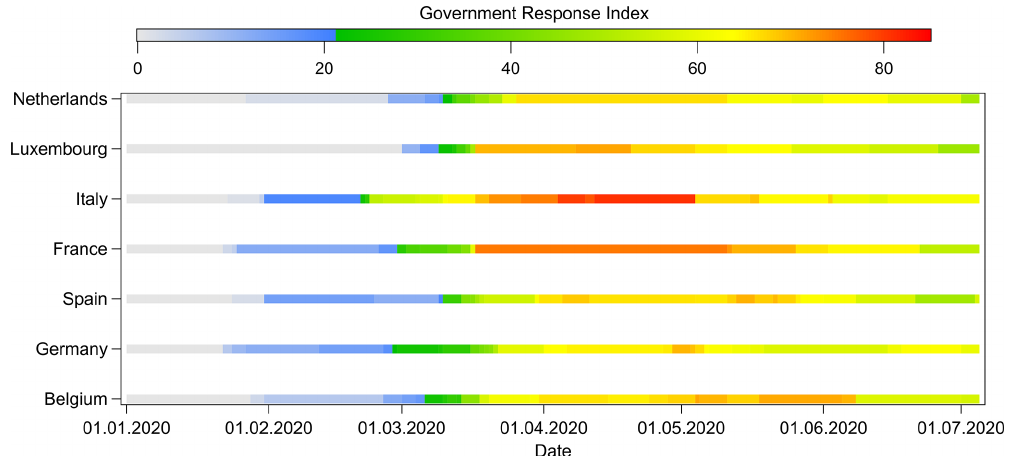
Figure 2. Temporal evolution of response on COVID-19 for selected European countries. Governmental response index data downloaded from https://github.com/OxCGRT/covid-policy-tracker/blob/3143b76020ef83072086853749c950ac0921ba47/data/timeseries/government_ response_index.csv (last access: 6 July 2021). Further details on the governmental response index in Hale et al.